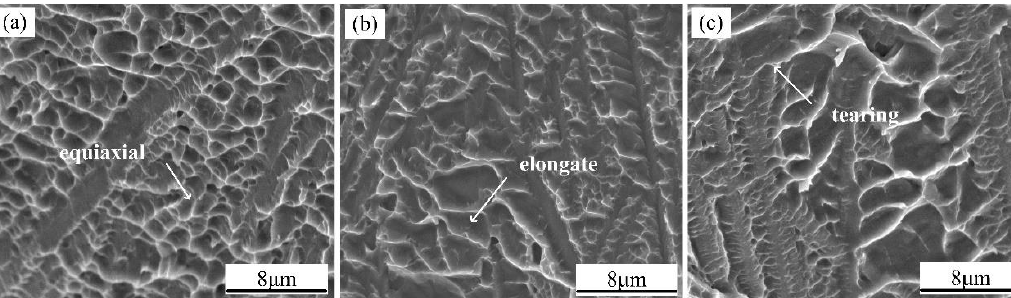
Figure 10. Low-magnification SEM fractographs of the joints welded at ( a ) E = 2.2 × 10 3 J/cm; ( b ) E = 3.4 × 10 3 J/cm; and ( c ) E = 5.5 × 10 3 J/cm.